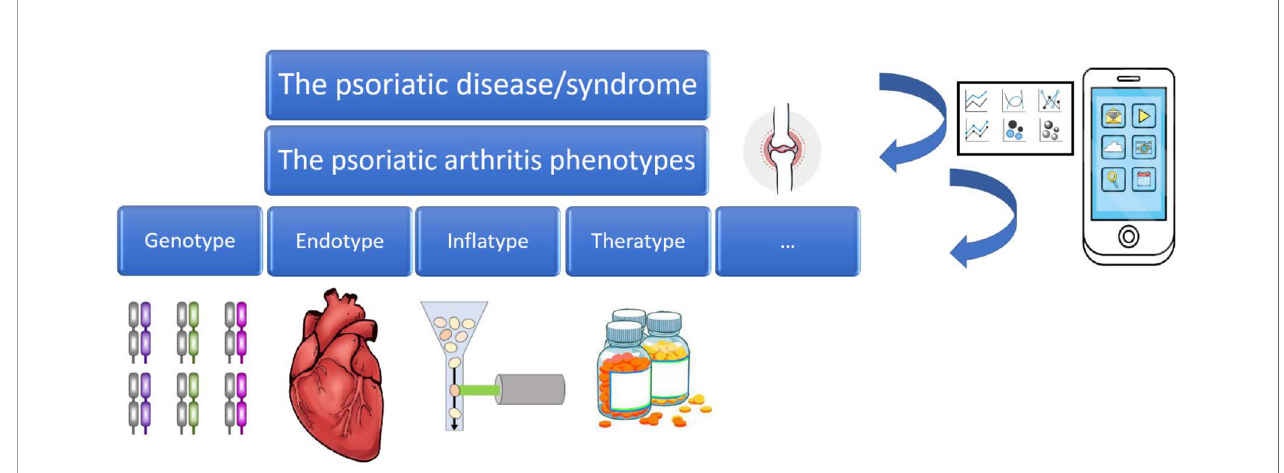
FIGURE 1 | The psoriatic disease/syndrome and its various phenotypes and endotypes, leveraged by Big Data, smart and digital technologies, and Arti fi cial